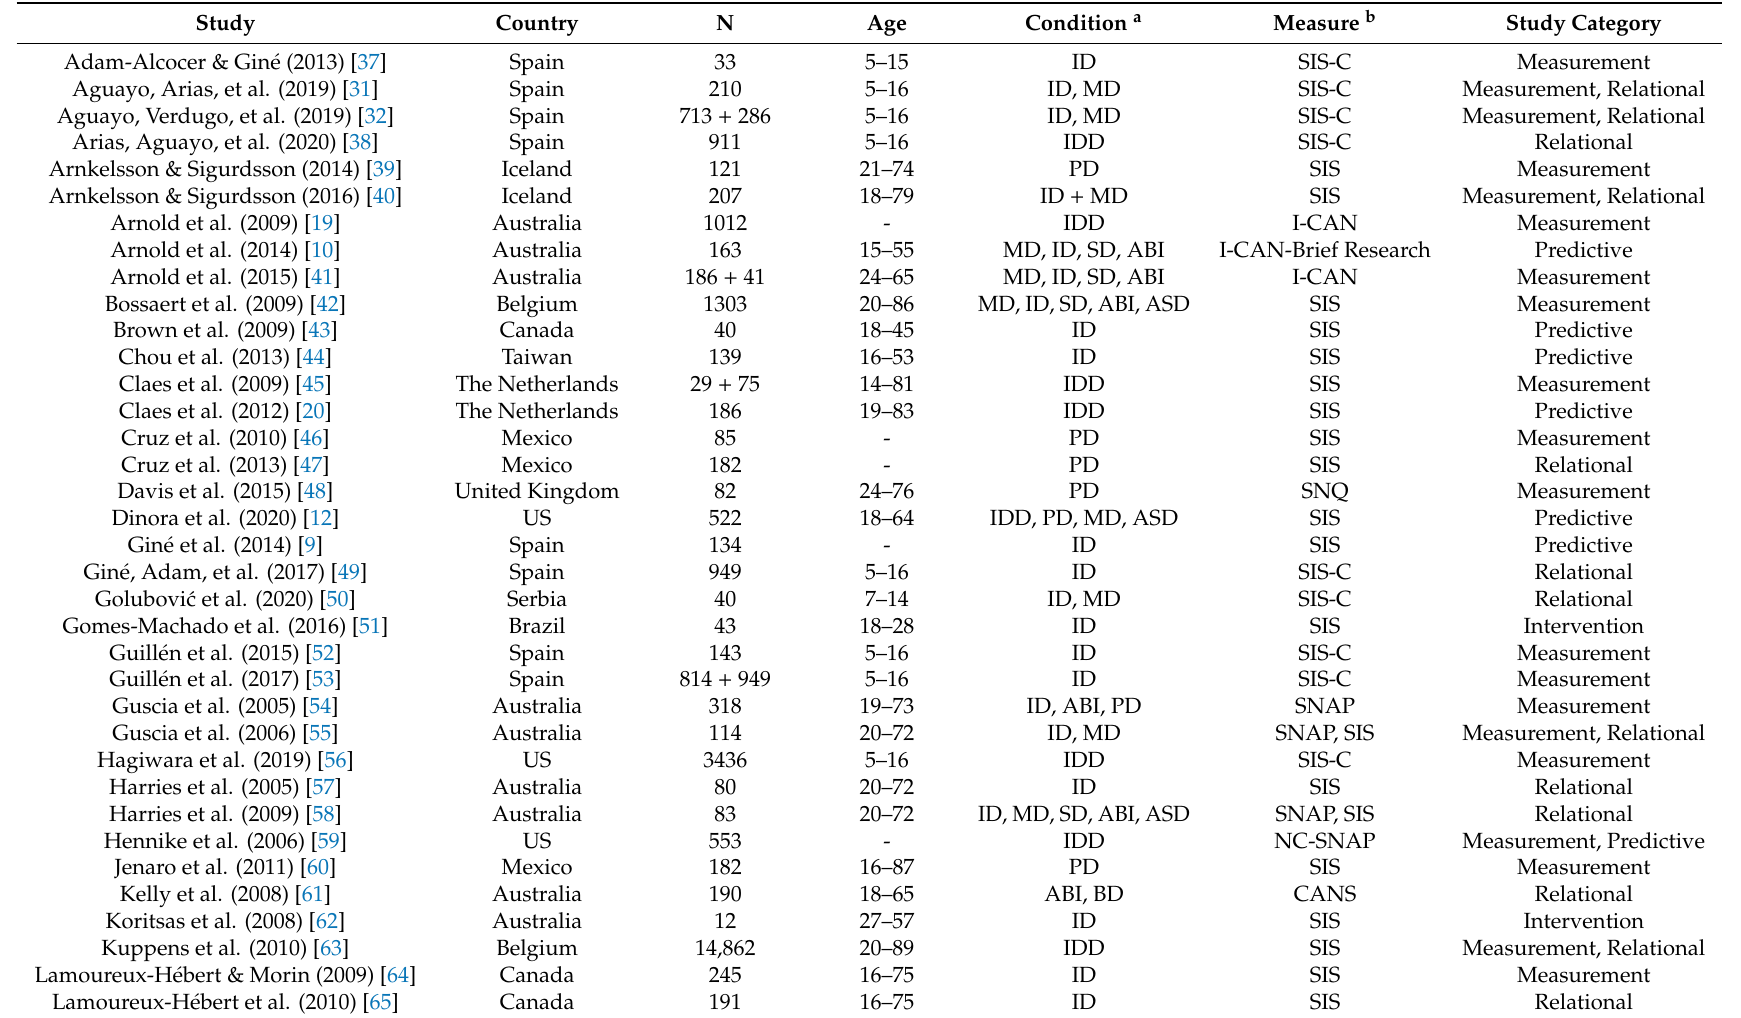
Table 1. Studies Comprising the Systematic Review (n =